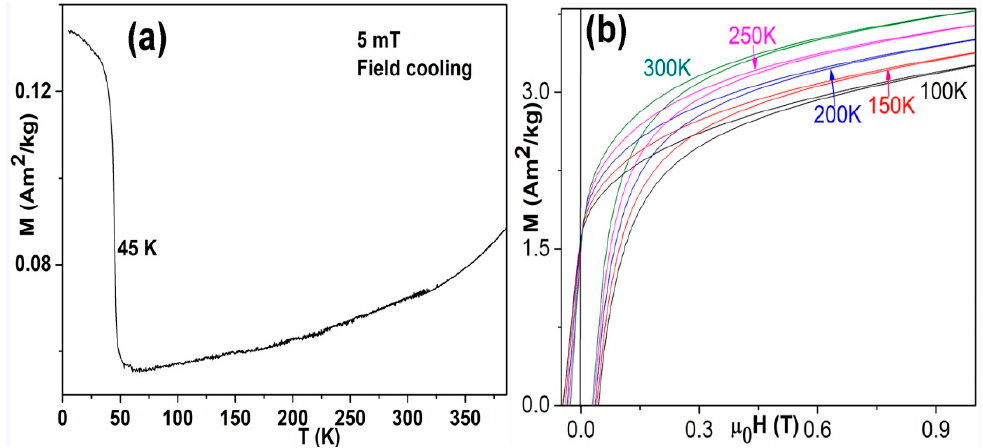
Figure 3. ( a ) The M-T curve of the field-cooled Mn–C nanoparticles measured with increasing temperature and under an applied field of 5 mT. ( b ) The magnetic hysteresis loops (quadrants 1 and 2) of the Mn–C nanoparticles at 100 K, 150 K, 200 K, 250 K, and 300 K,